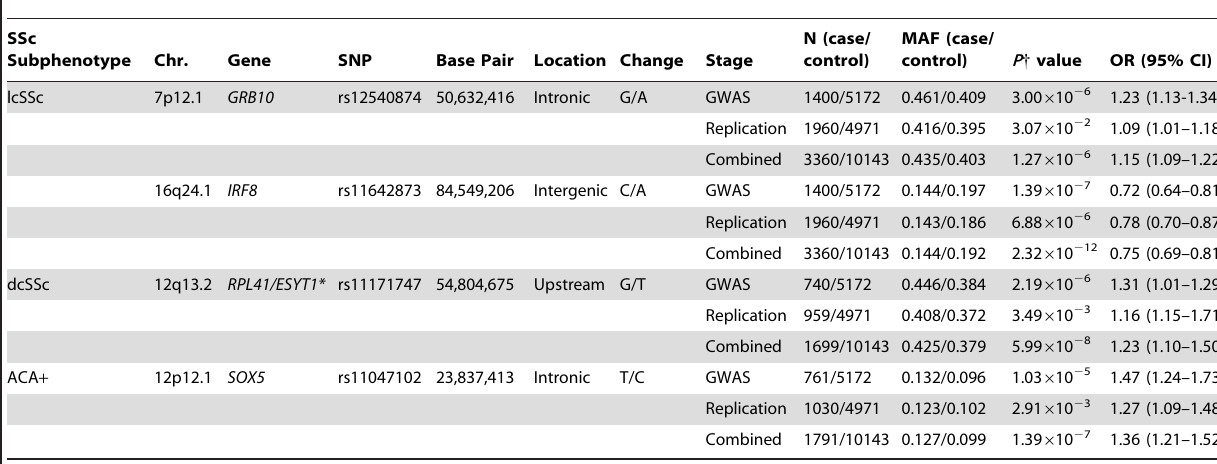
Table 1. Novel non-HLA loci associated with SSc clinical and serological subtypes.